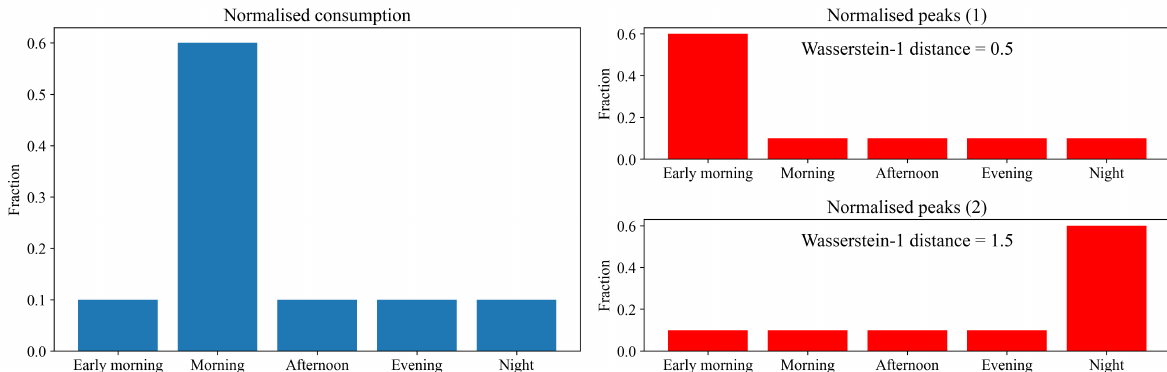
Figure 6. Illustration of how the Wasserstein distance is able to capture chronological differences between the probability distributions of consumption and peak